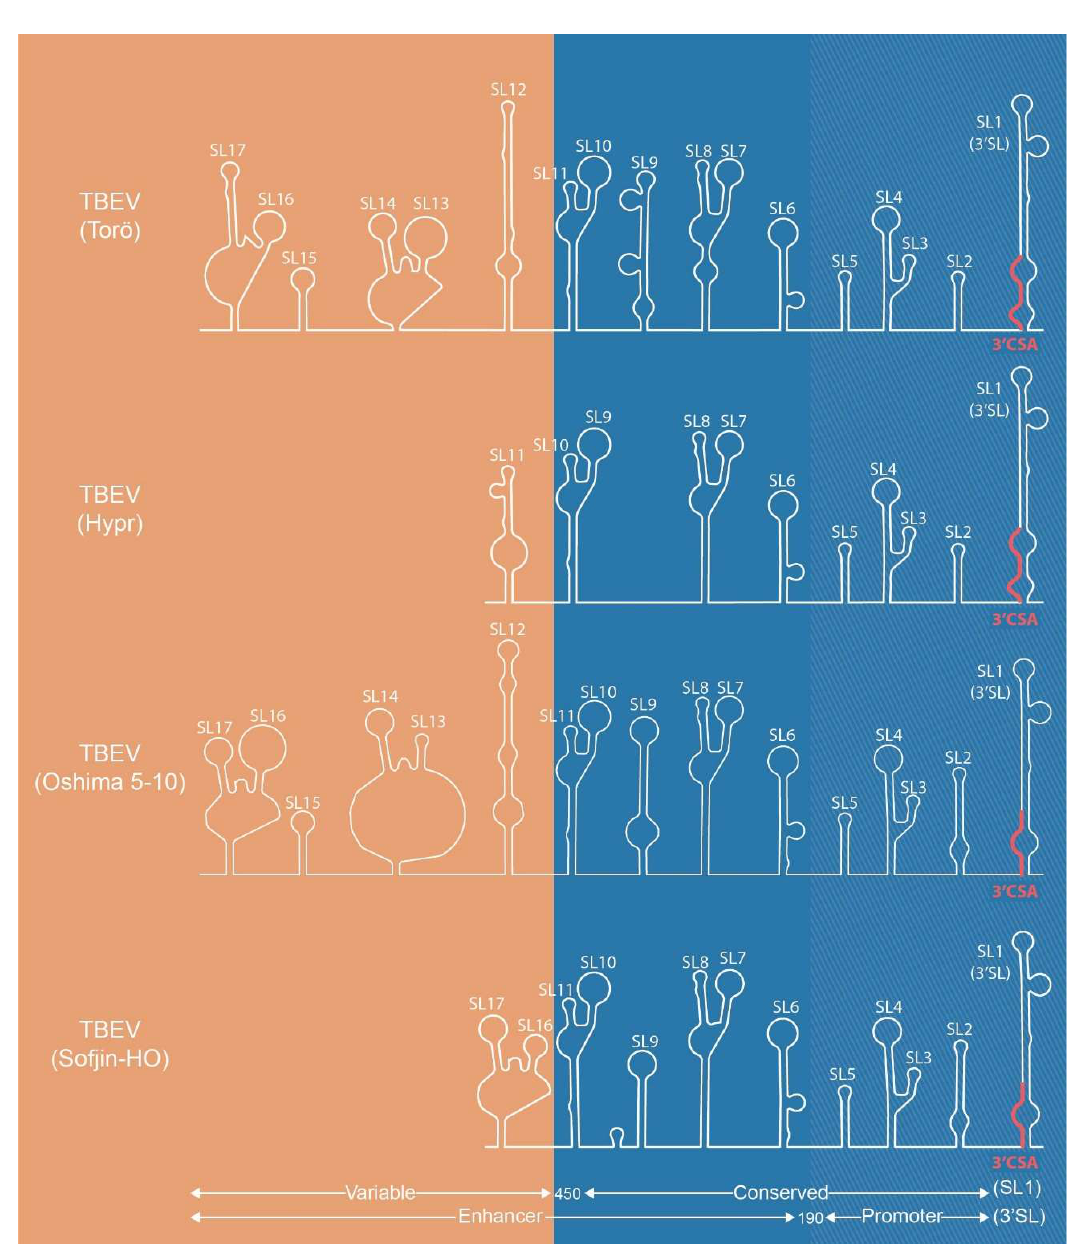
Figure 2. Predicted secondary structure of the 3′UTR of TBEV-Eu strains Torö (accession no. DQ401140) and Hypr (accession no. U39292), and TBEV-FE strains Oshima 5-10 (accession no. AB062063) and Sofjin-HO (accession no. AB062064). Secondary structures were predicted using Mfold (http://unafold.rna.albany.edu/?q=mfold/RNA-Folding-Form). The 450 nt conserved region of the UTR (shown in blue) is comprised of the enhancer element and the terminal 190 nt promotor element, with the promoter element, including the 3′SL, being essential for replication. The nucleotides between the coding region and the terminal end of the UTR are referred to as the variable region (shown in orange). Variation in the length of the UTR among strains is due to deletions in the variable regions and correlates to virulence.